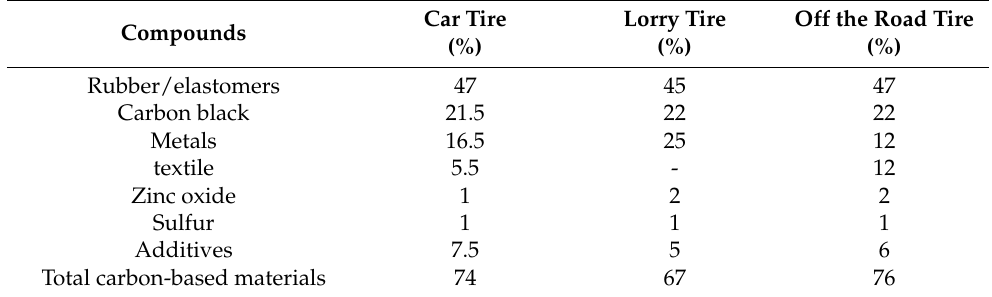
Car Tire Lorry Tire Off the Road Tire (%) (%) (%)